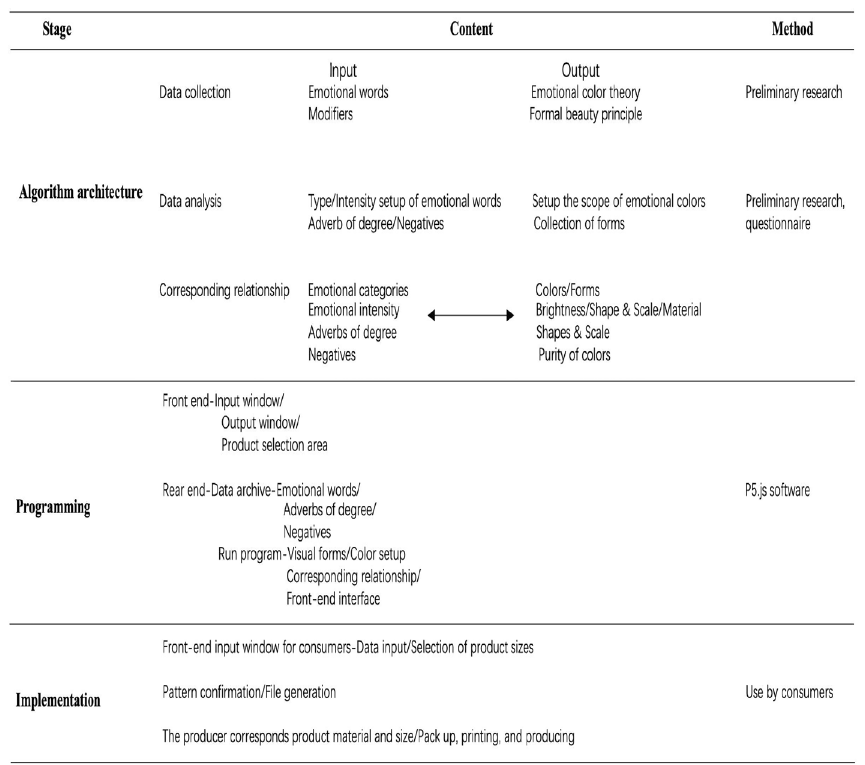
Table 1 Stages in the personalized design